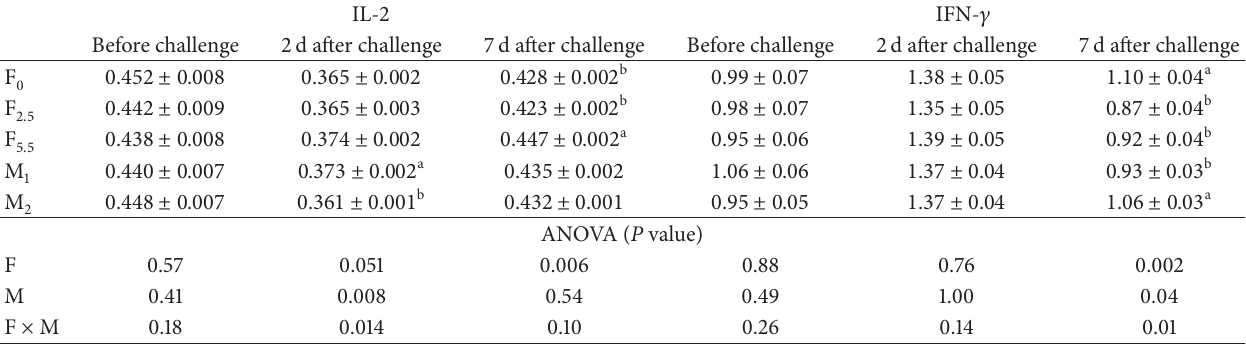
Table 7: Effect of fish oil and methionine supplementation on serum IL-2 and IFN- 𝛾 levels (pg/mL) in broiler chickens challenged with IBD. IL-2 IFN- 𝛾 Before challenge 2d after challenge 7d after challenge Before challenge 2 d after challenge 7d after challenge 0.452 ± 0.008 0.365 ± 0.002 0.428 ± 0.002 b F 0